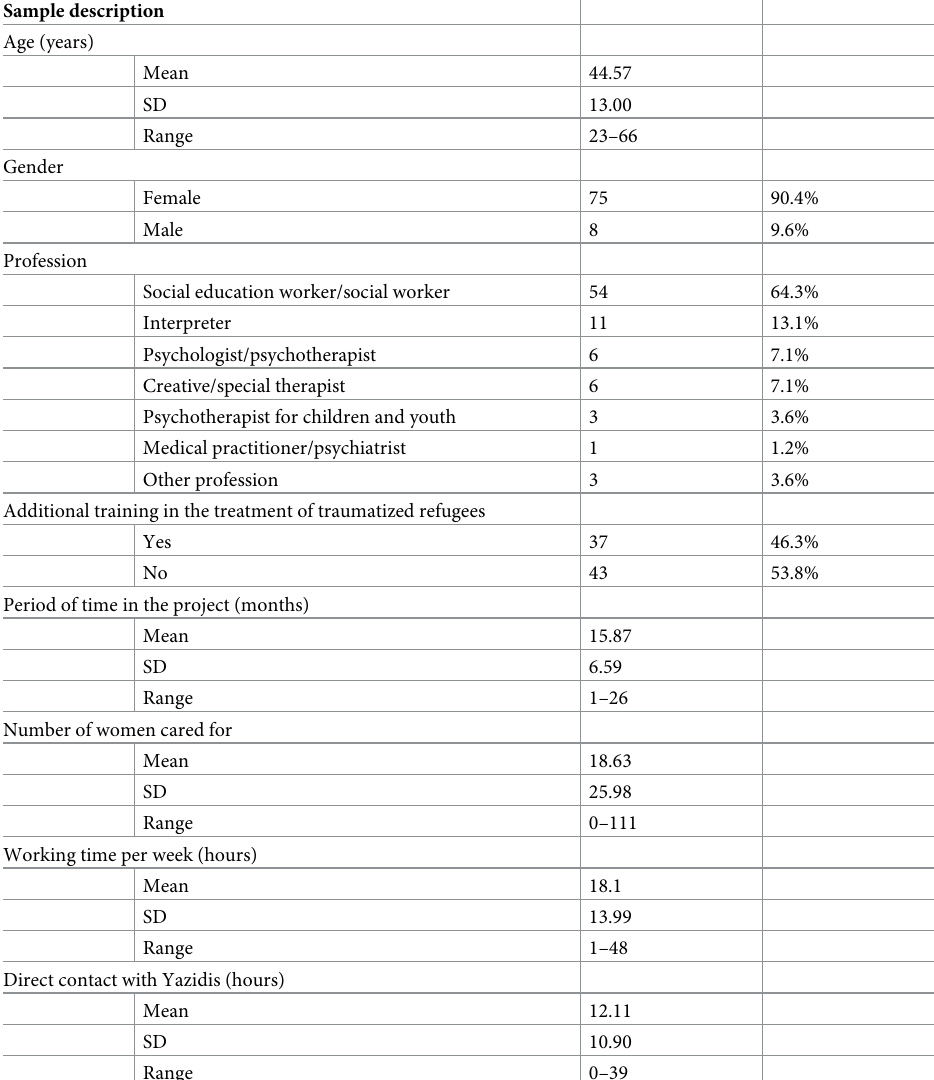
Table 1. Sociodemographic data and working conditions of the care providers in the